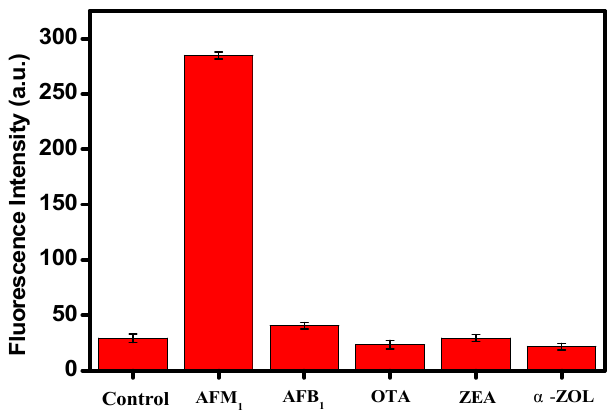
Figure 4. Fluorescence intensity in the absence (control) and presence of 4 ng mL − 1 of the mycotoxins AFM 1 , AFB 1 , ochratoxin A (OTA), zearalenone (ZEA) and α -zearalenin ( α -ZOL). The experiment conditions were as follows: Excitation wavelength ( λ ex ) at 480 nm, 200 nM of AFM 1 aptamer, 20 μ g mL − 1 of GO, 200 U of DNase I. Every data point is the mean of three replicates.